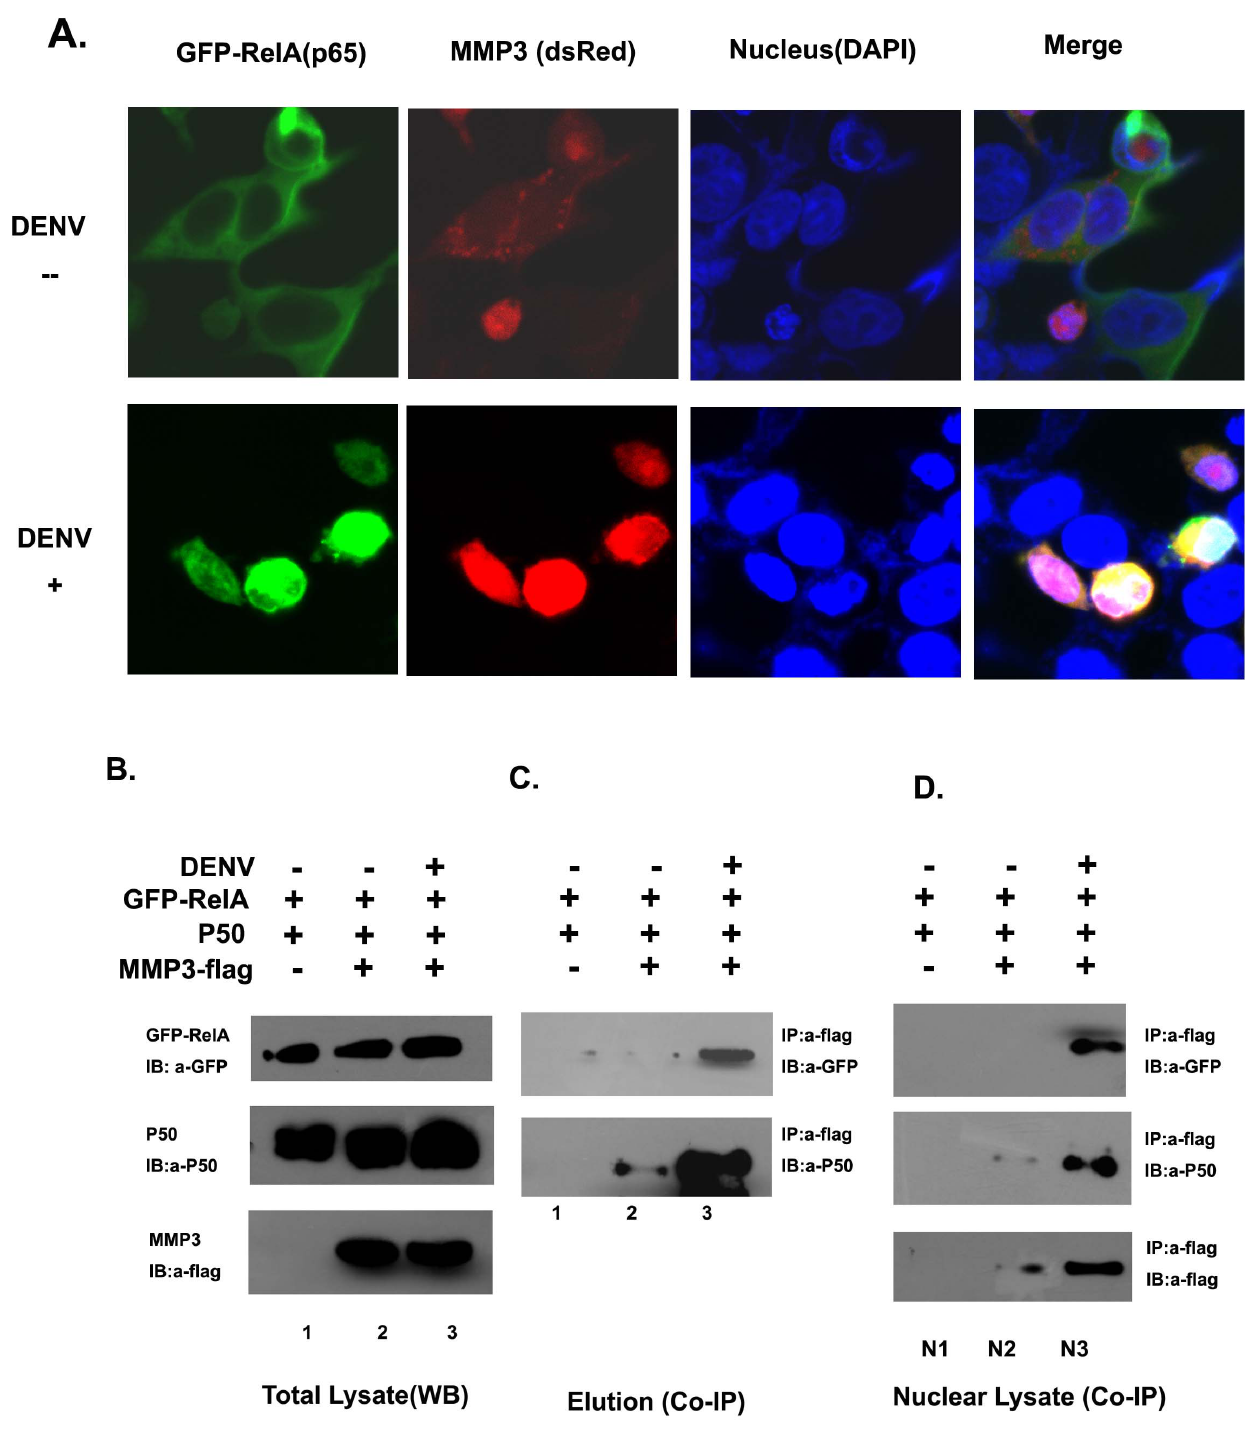
Figure 5. MMP3 interacts with NF k B in cell nucleus upon DENV infection. A) Co-localization of MMP3 and NF k B RelA(p65) in cell nucleus upon DENV infection. B and C) NF k B RelA (p65) and P50 were co-immunoprecipitated with MMP3 in total cell extract from DENV infected cells. The co-IP was carried out using anti-flag affinity gel and the bound proteins were detected by immunoblotting with anti-GFP, anti-P50 and anti-flag antibodies, respectively. D) NF k B RelA (p65) and P50 were co-immunoprecipitated with MMP3 in cell nucleus upon DENV infection. Representative results from at least 3 independent experiments.